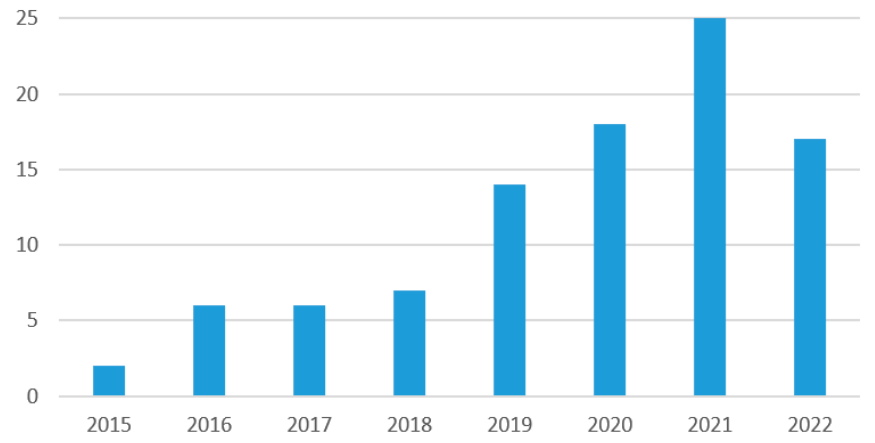
Figure 2. Results distribution by publishing year.